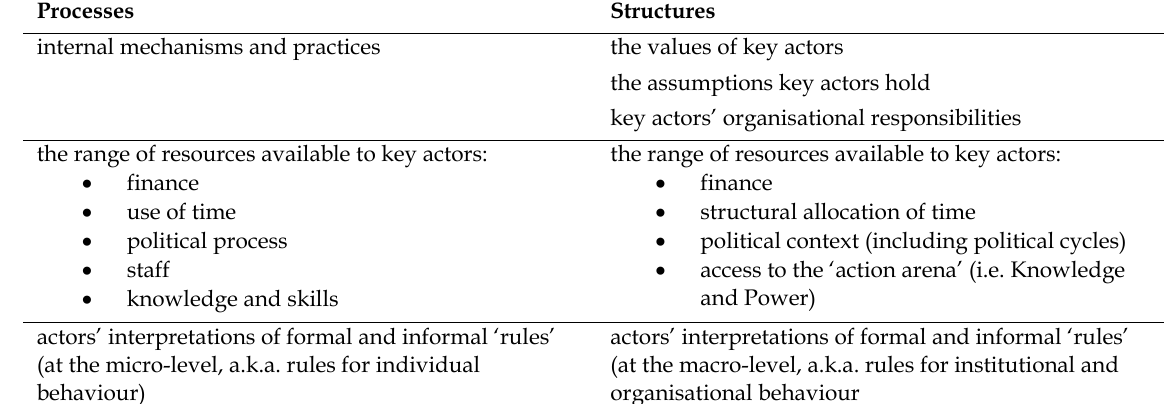
Table 1. The relationship between process & structure and the issues influencing organisational delivery (after Forrester et al., 2006) Processes Structures the assumptions key actors